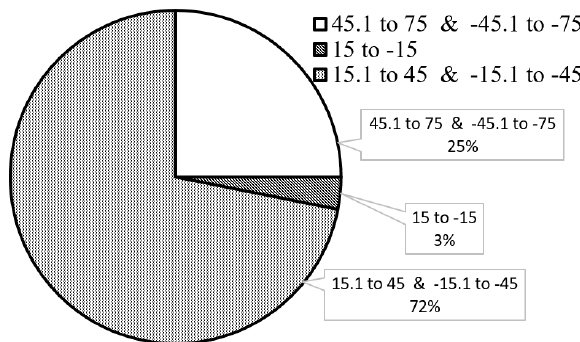
Figure 8. Categorization of the articles that focused on renewable energy resources according to the authors’ location.